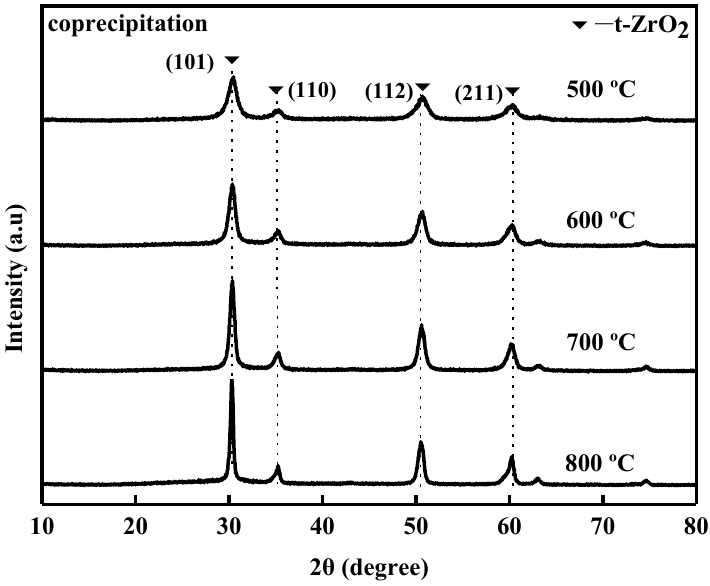
Figure 5. XRD pattern of MgZr-c prepared using the coprecipitation method.